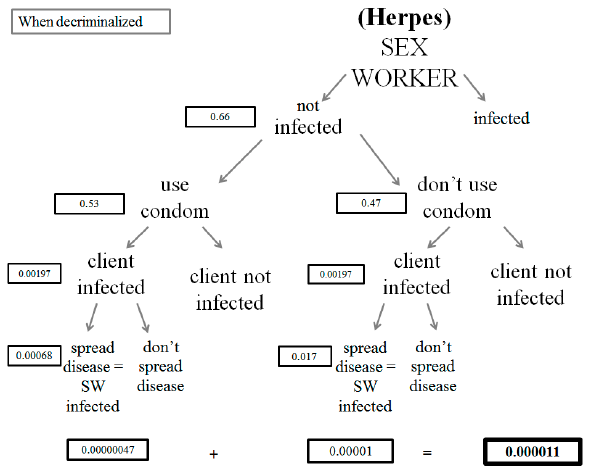
Figure A10. Risk of herpes transmission to a sex worker under criminalization.